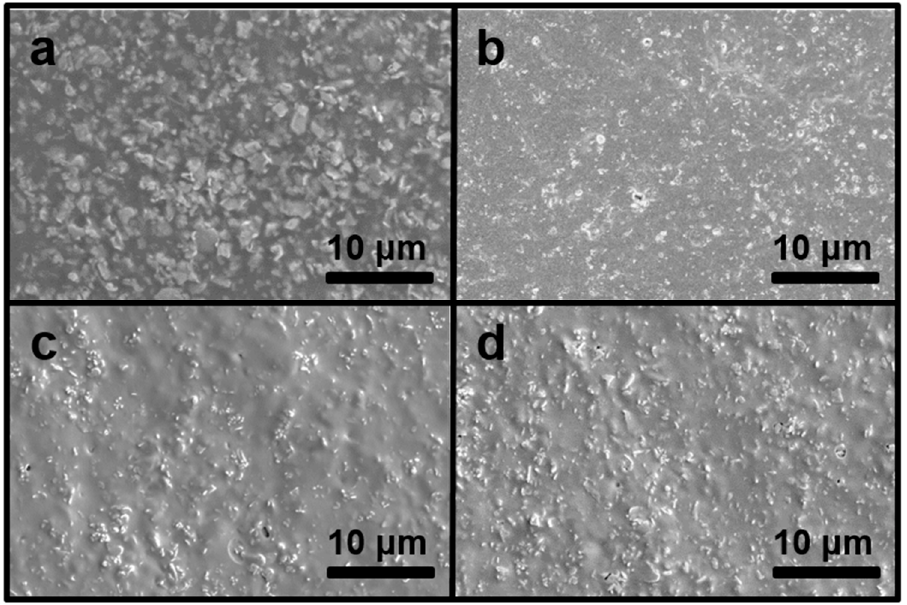
Figure 3. SEM observation of HPMC/MoS 2 /Cu composites: ( a ) HPMC/MoS 2 , ( b ) Cu 1 wt.%, ( c ) Cu 2 wt.%, and ( d ) Cu 3 wt.%.